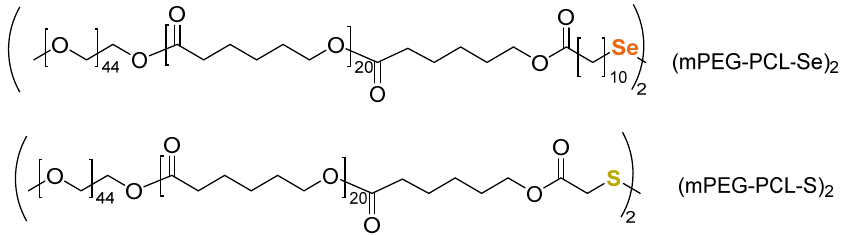
Figure 18. Structures of disulfide- and diselenide-linked PCL and PEG triblock copolymers syn- thesized by Zhang et al. [80]. sized by Zhang et al.